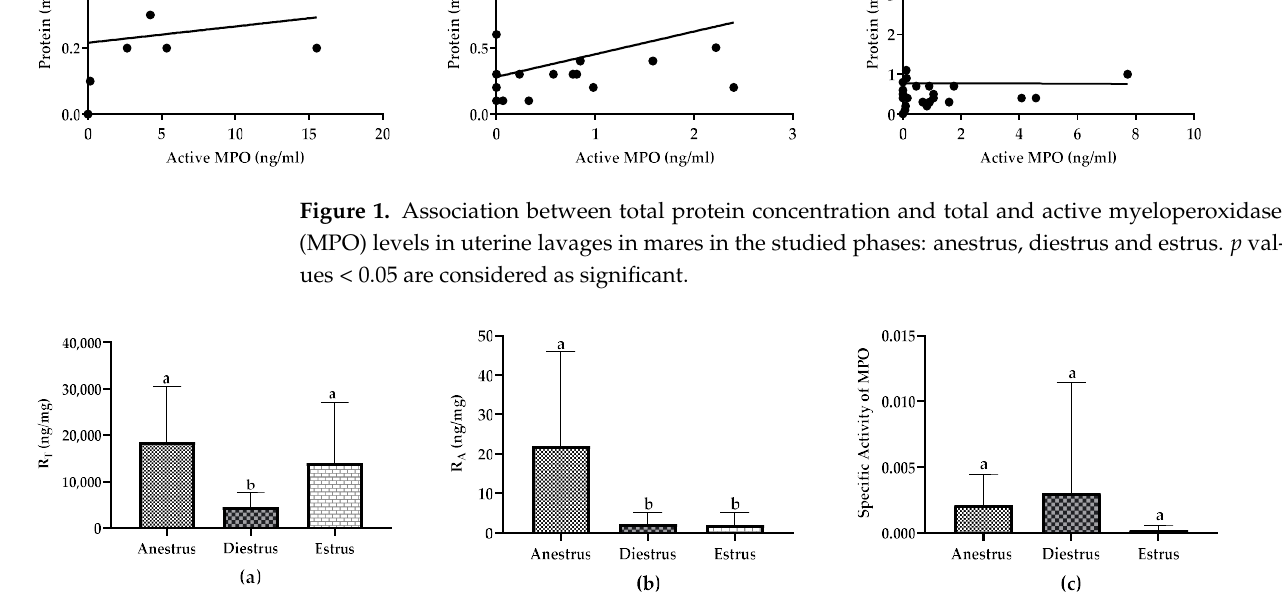
Figure 1. Association between total protein concentration and total and active myeloperoxidase (MPO) levels in uterine lavages in mares in the studied phases: anestrus, diestrus and estrus. p val- ues < 0.05 are considered as significant.